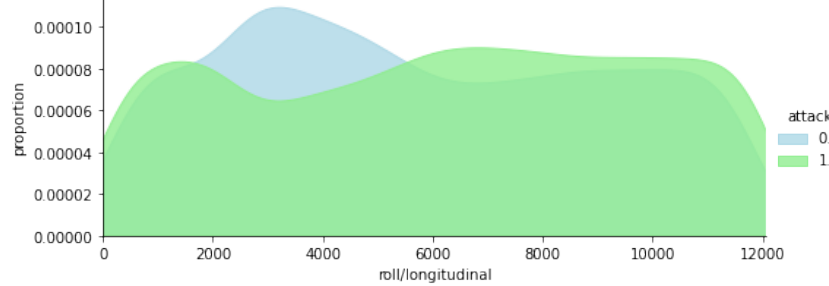
Figure 7. Numerical feature analysis of attacked longitudinal and roll motions.